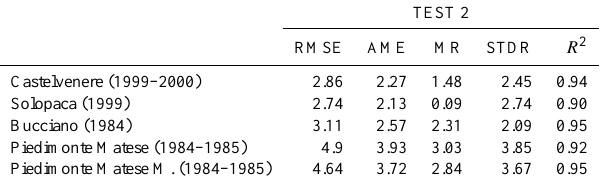
Table 10. Statistics of the Test 2 (values in K). Error statistics of T a estimates in different periods of time using the mean of the Fourier coefficients from 2001 to 2011.